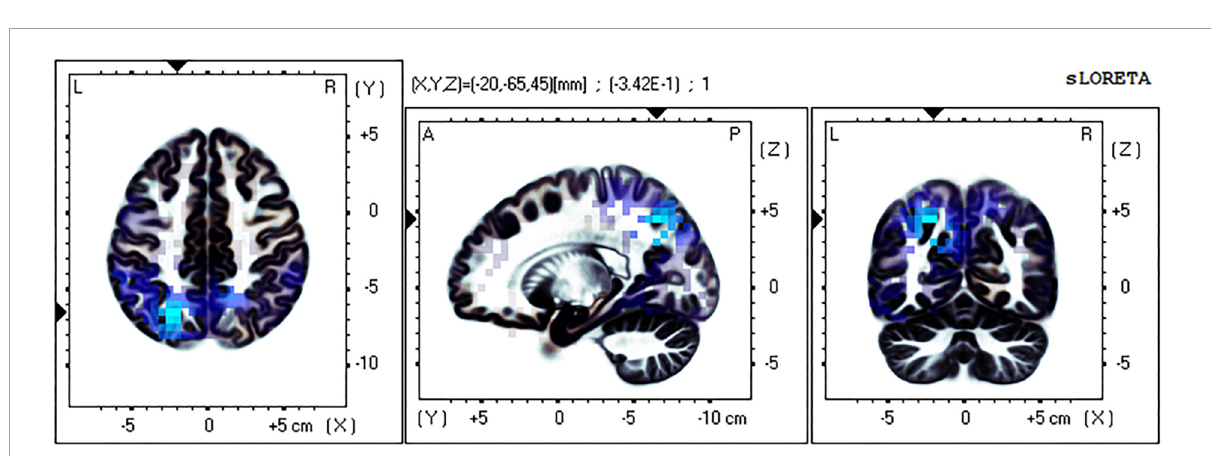
FIGURE4 Brain source localization results of current density difference corresponding to 300–500 ms ERP data of mental rotation task after sleep deprivation and before sleep deprivation under the identical condition. Blue indicates the activation of these brain regions is significantly lower after TSD than before; Red indicates that the activation of these brain regions is significantly higher after TSD than before; from left to right: the axial, sagittal, and coronal planes, respectively. L, left; A, anterior; R, right; P,